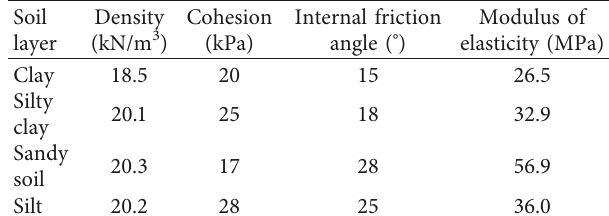
Figure 1: Geological profile and supporting structure system. Table 1: Soil mechanics parameter